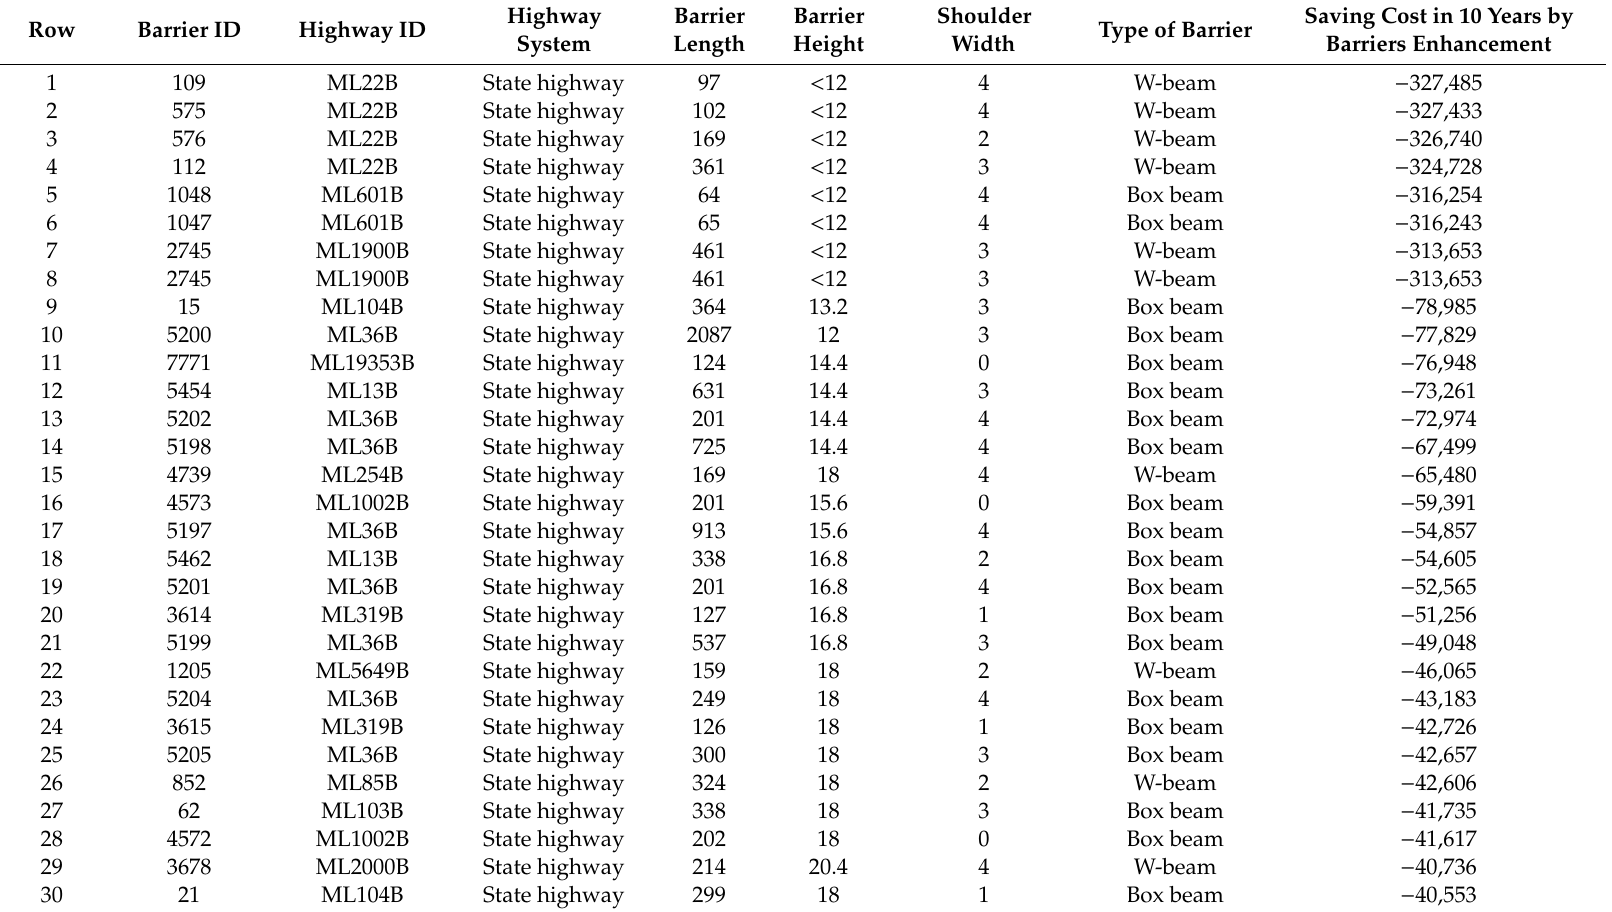
Table 3. The top critical barriers sorted based on the highest